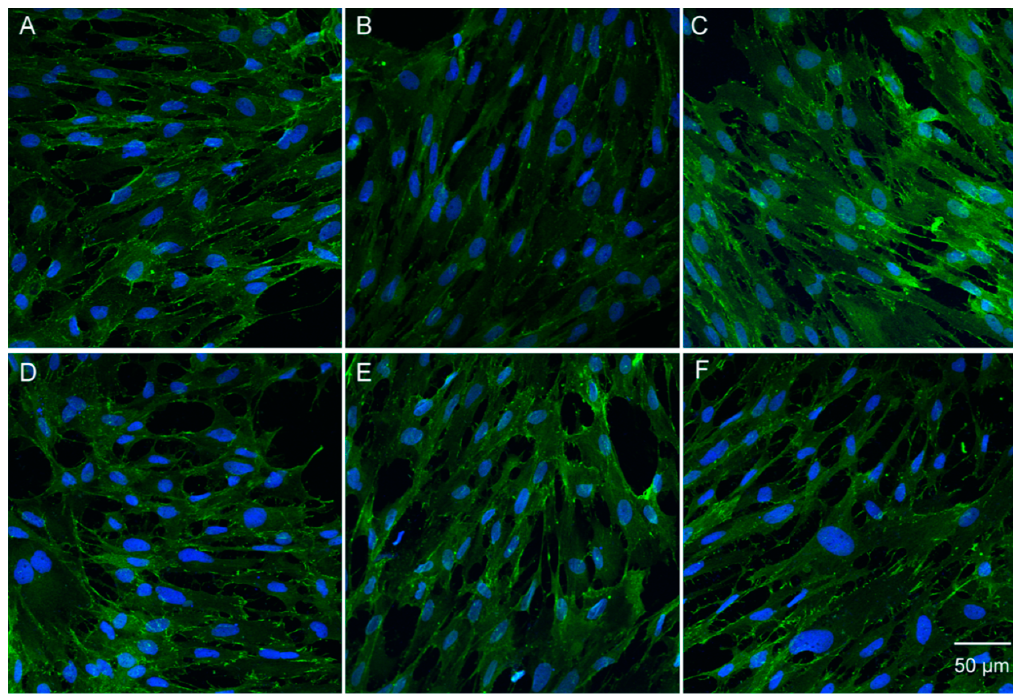
Figure 7. The effects of catalpol on ZO-1 decreased expression induced by LPS detected by immunofluorescence staining. ( A ) normal group; ( B ) model group; ( C ) Fasudil group; ( D ) catalpol 0.3 μ M group; ( E ) catalpol 3.0 μ M group; ( F ) catalpol 30.0 μ M group. Molecules 2018 , 23 , x